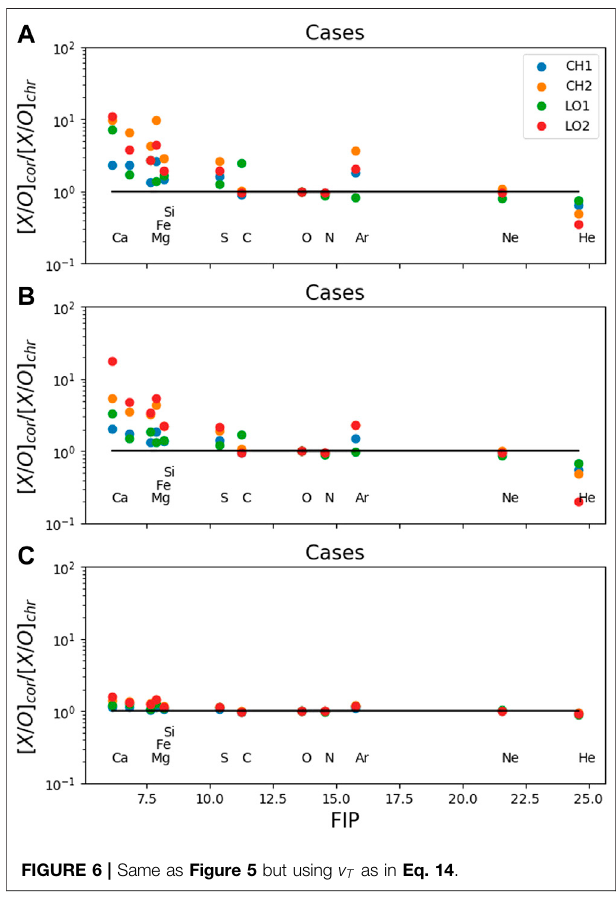
FIGURE 6 | Same as Figure 5 but using v T as in Eq. 14